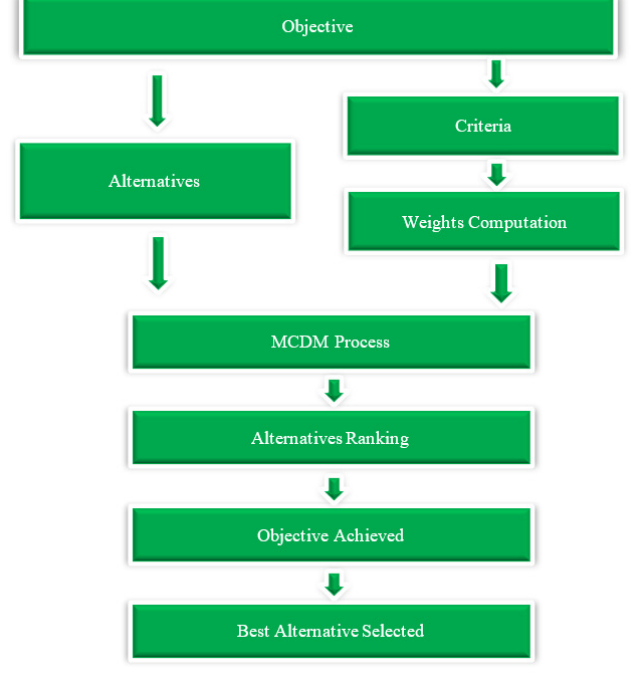
Figure 2. Flowchart of MCDM process.